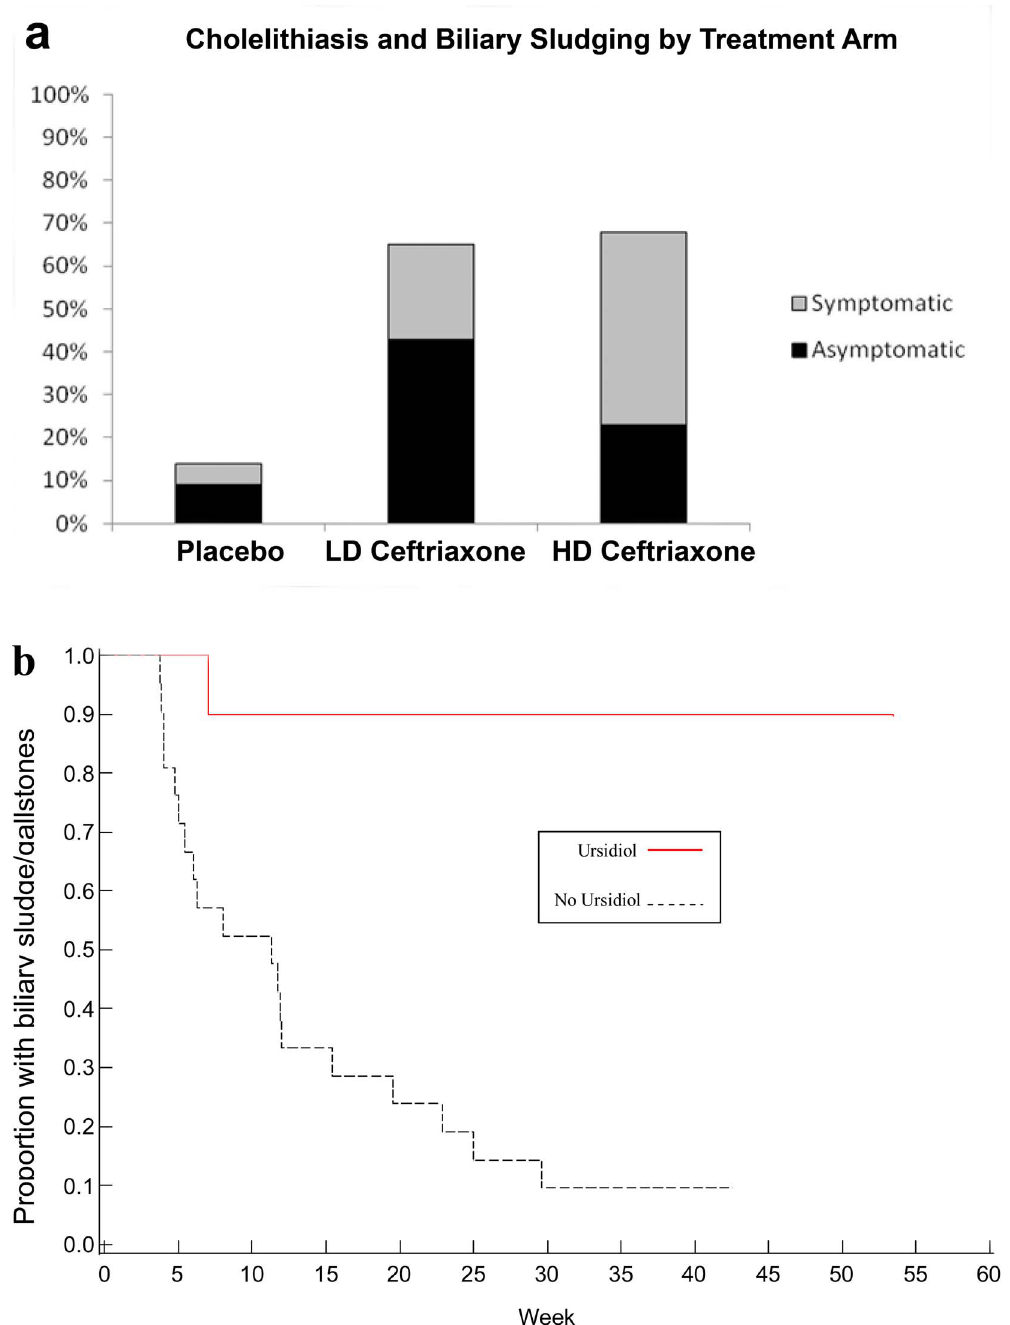
Figure 5. Cholelithiasis and Biliary Sludging by Treatment Arm. (a) Biliary sludging and cholelithiasis were more common in the low dose (LD) and high dose (HD) treatment arms than in the placebo treatment arm (p , 0.01; Jonckheere-Terpstra). (b) Treatment with ursodiol significantly shortened event duration when used to treat cholelithiasis and biliary sludging (p,0.001; Log-Rank).